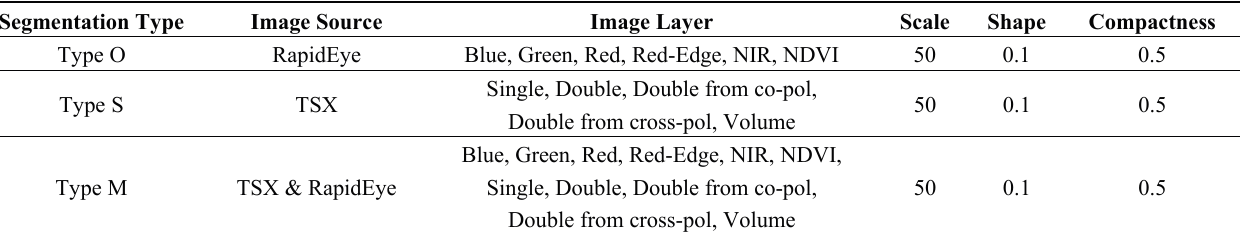
Table 2. Parameter settings for image